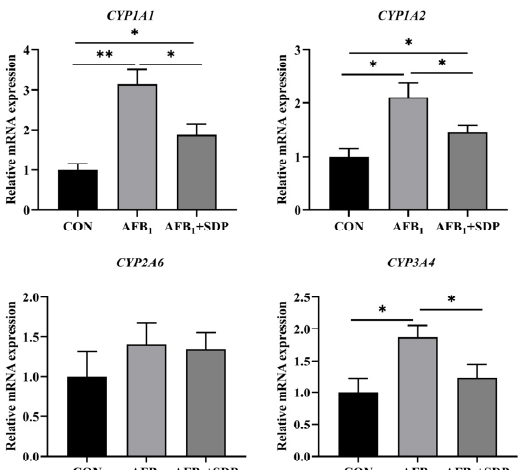
Figure 4. The protective effects of dietary seaweed ( Enteromorpha prolifera )-derived polysaccharides on hepatic mRNA expression of phase I detoxification enzyme-related genes in broiler chickens. * p < 0.05, ** p < 0.01, no superscript marks indicated that p > 0.10. CON: control group; AFB 1 group: (fed diet with 0.1 mg/kg AFB 1 ); AFB 1 + SDP group (AFB 1 group + 0.25% SDP).